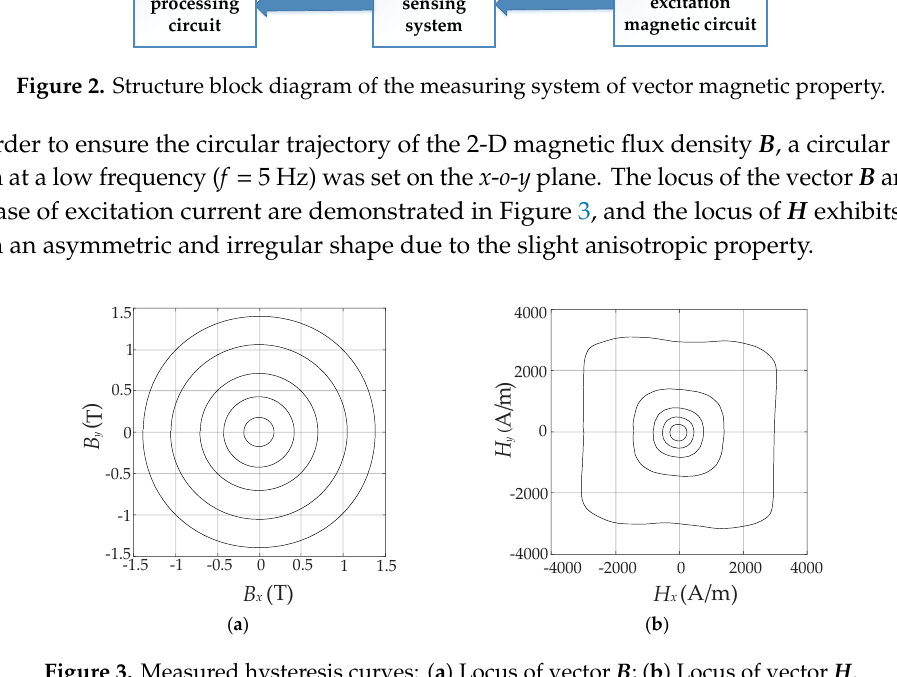
Figure 4. Measured concentric hysteresis loops in two orthogonal directions: ( a ) In x direction; ( b ) In y direction.